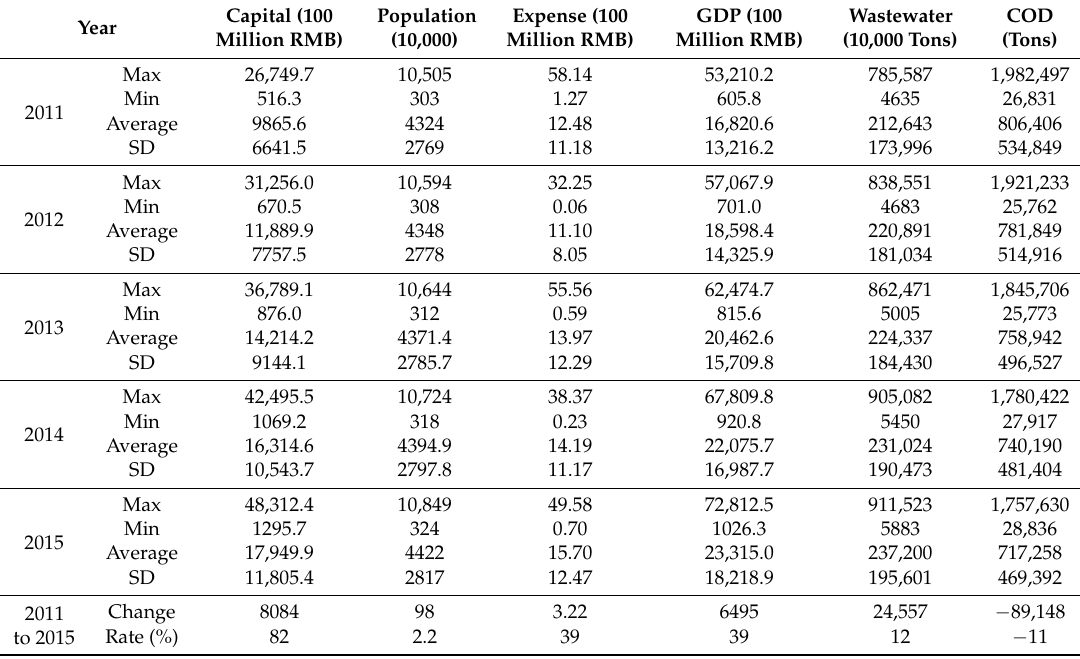
Table 2. Descriptive statistics of input–output